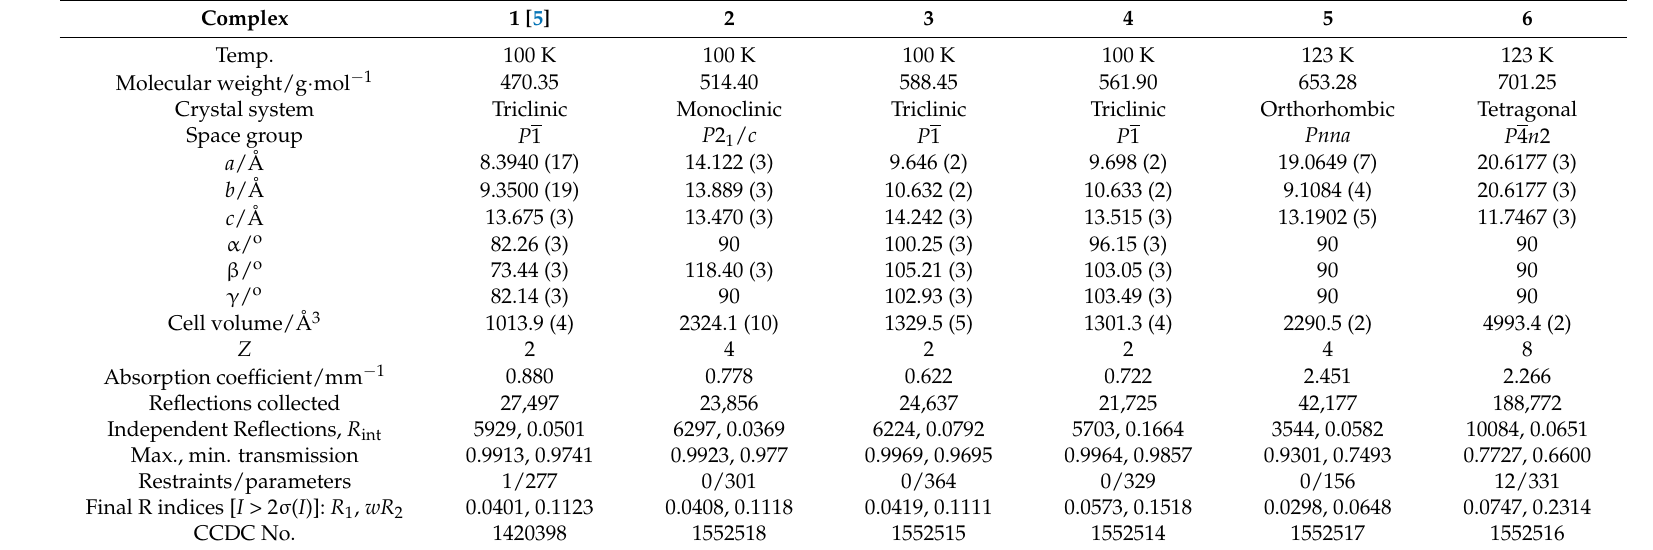
Table 1. Crystallographic data and structure refinement for 1 – 6 .